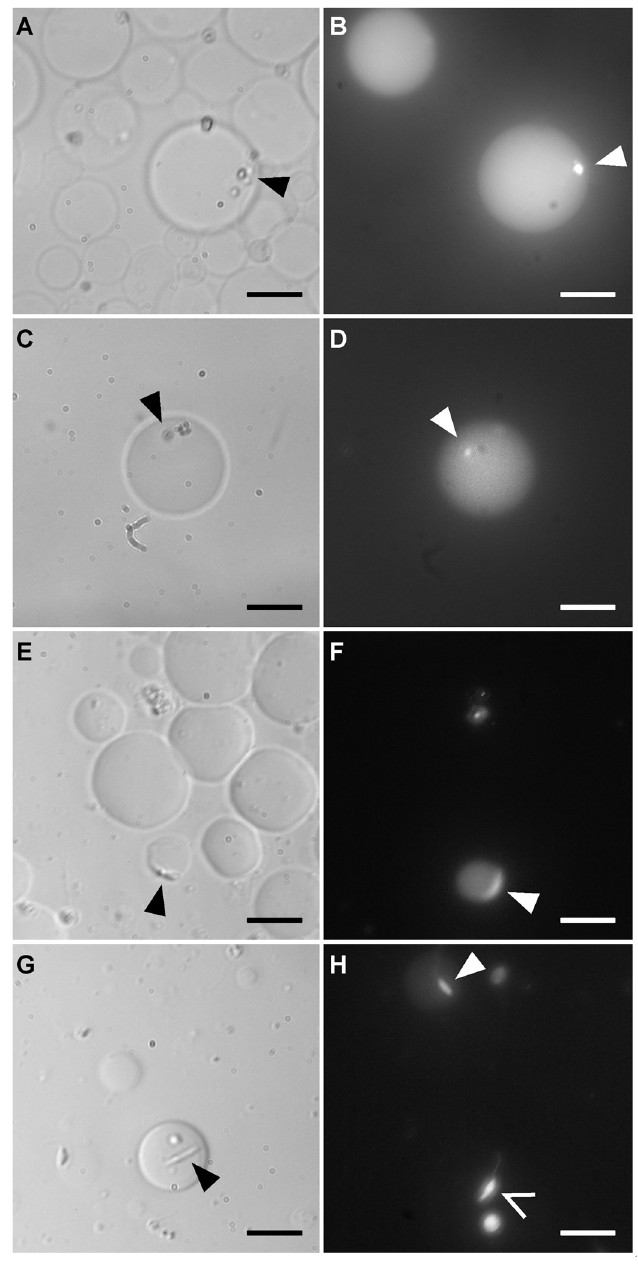
Fig 4. Observation of living L . amazonensis in liposomes. Liposomes containing parasites in RPMI-Dextran were incubated with Calcein before observation in phase contrast (left images) and fluorescence microscopy (right images). Liposomes are fluorescent due to the encapsulated living parasites (arrowhead) which expelled fluorescent Calcein after their uptake. (A-B and C-D) after 48h at pH 5.5 at 37°C; A and B: same field; C and D: same field. (E-F, G and H) after 48h at pH 7.5 at 24°C; E and F: same field. Promastigotes present elongated shapes. The empty arrow in H shows a living parasite, whose liposome had just broken. The flagellum is visible. Scale bar: 10 μ